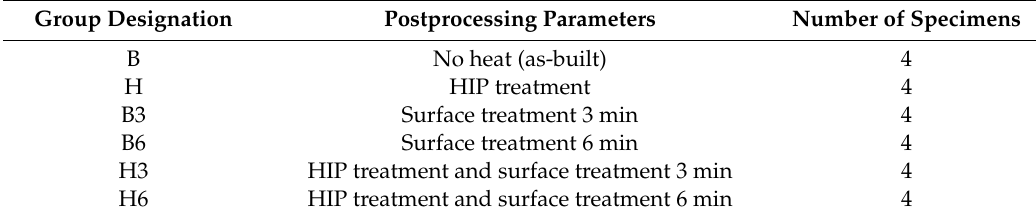
Table 2. Experiment plan-specimen designation system, corresponding group definition and number of specimens per